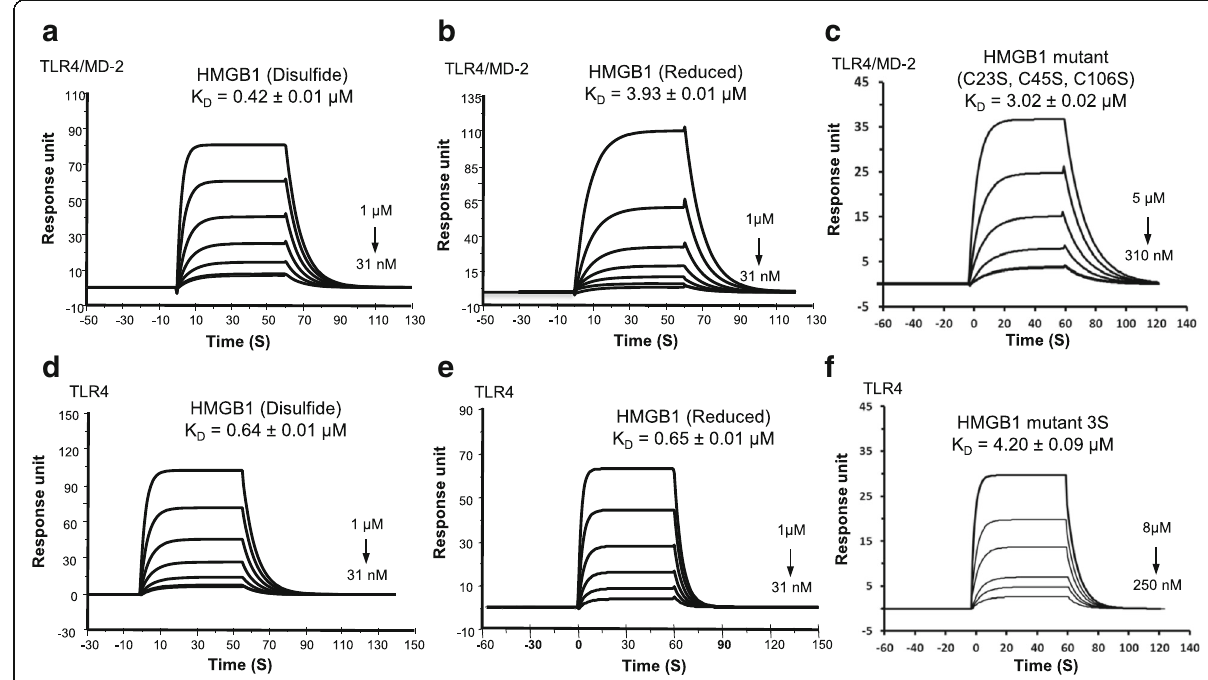
Fig. 2 SPR analyses of redox forms of HMGB1 binding to TLR4/MD-2 complex or TLR4. a - c TLR4/MD-2 complex was coated on the CM5 chip; disulfide HMGB1 binds to complex with a K D of 0.42 ± 0.01 μ M; reduced HMGB1 binds with a K D of 3.93 ± 0.01 μ M; HMGB1 3S mutant binds with a K D of 3.02 ± 0.02 μ M. d - f TLR4 was coated on the chip; HMGB1 binds to TLR4 with a K D of 0.64 ± 0.01 μ M; reduced HMGB1 binds with a K D of 0.65 ± 0.01 μ M; HMGB1 3S mutant binds with a K D of 4.20 ± 0.09 μ M. Data are representative of three